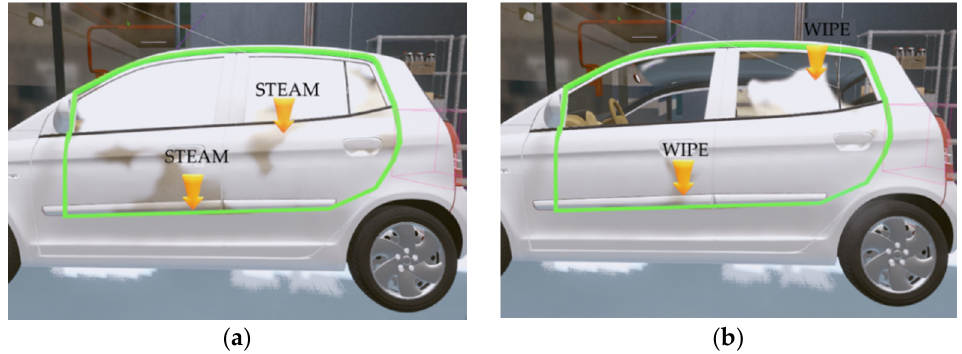
Figure 18. Indication of areas with low scores: ( a ) Stem-spraying; ( b ) Mop-wiping.